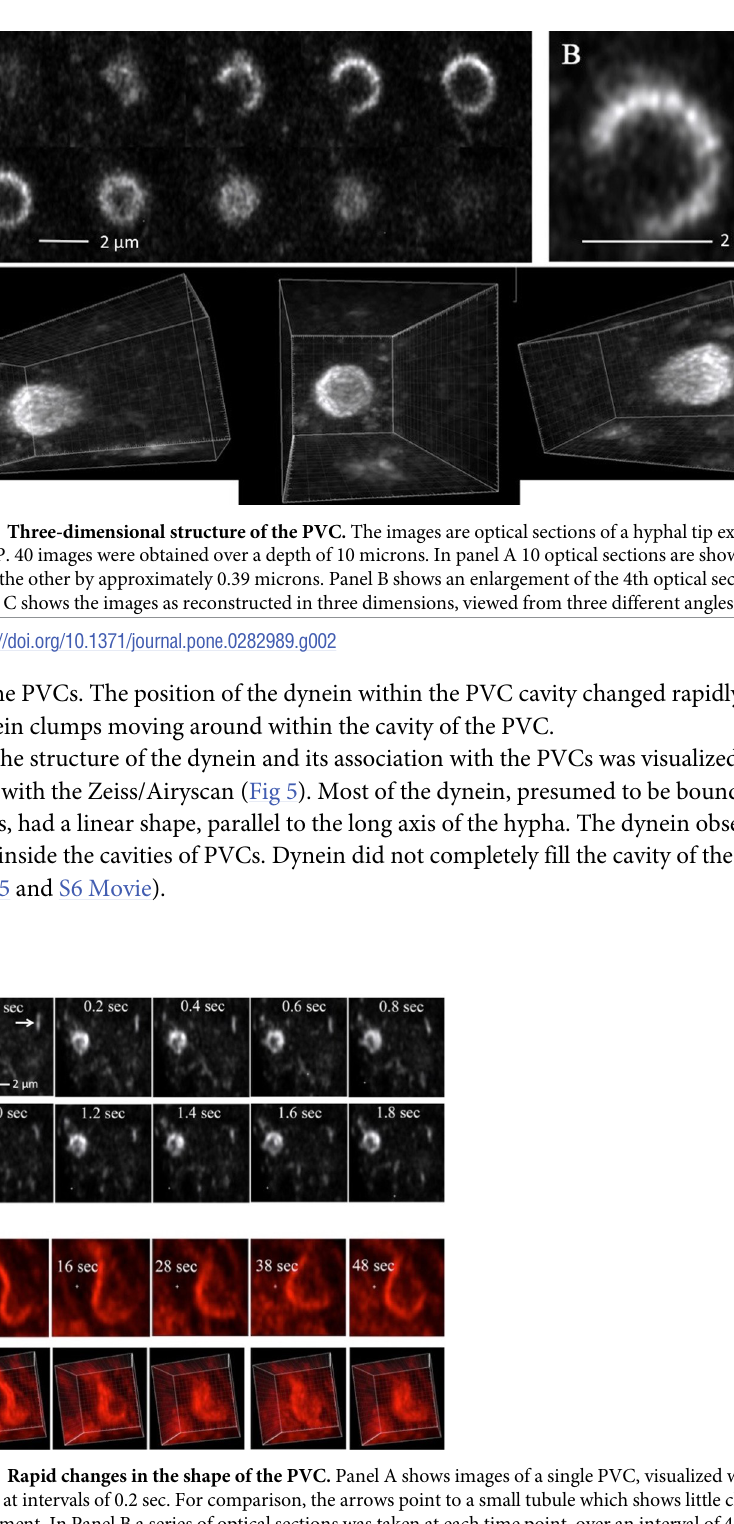
Fig 3. Rapid changes in the shape of the PVC. Panel A shows images of a single PVC, visualized with RAB-7-RFP, taken at intervals of 0.2 sec. For comparison, the arrows point to a small tubule which shows little change in shape or movement. In Panel B a series of optical sections was taken at each time point, over an interval of 48 sec. For each of the five images a single optical section is shown on top, and the three-dimensional reconstruction from that set of optical sections is shown below. The three-dimensional images are slightly tilted for better observation of the